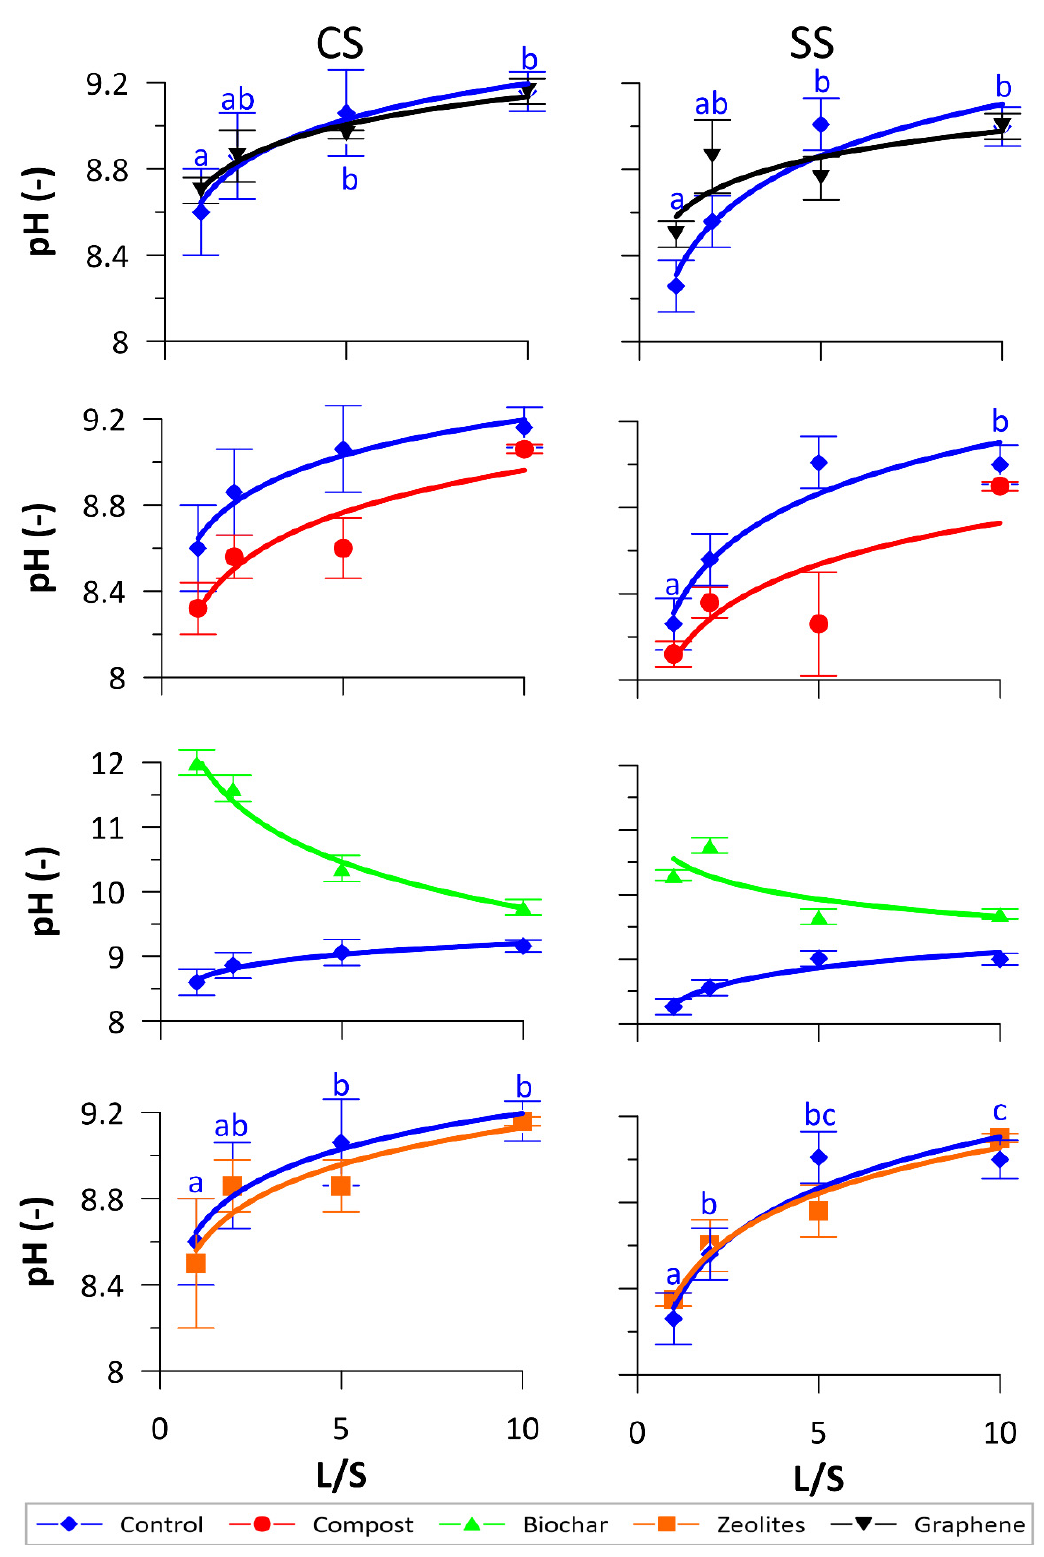
Figure 4. pH in SSE batches with CS ( left panels ) and SS ( right panels ) soils versus L/S ratios values at the end of the monitoring period. Error bars denote standard deviation calculated on three replicates, while lines are the best fit natural logarithmic curves. Different letters indicate statistically different means at 0.05 confidence.